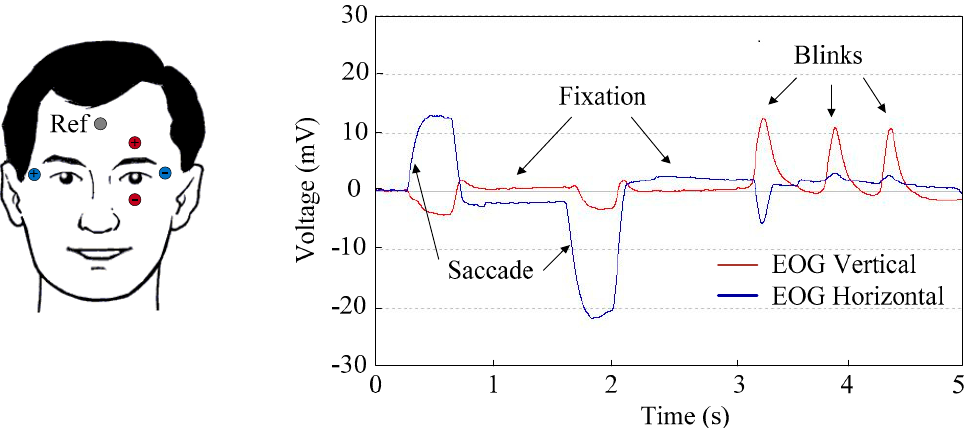
Figure 3. EOG showing saccadic and fixation eye movements as well as blinks. Red and blue waveforms represent the vertical and horizontal potentials, respectively. They are acquired by the electrodes of the same color. The gray electrode is the reference